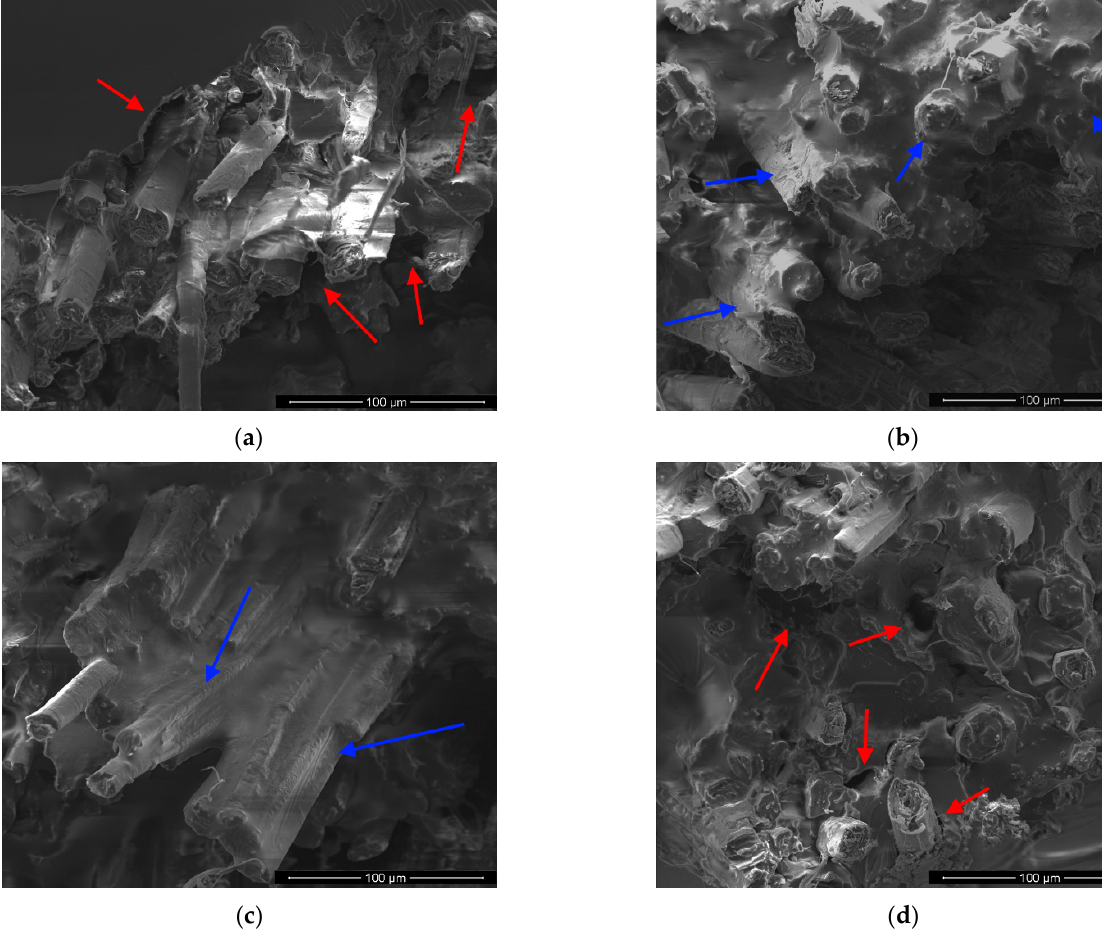
Figure 10. SEM micrographs at high magnification (1000×) of tensile fractured surfaces: ( a ) R, ( b ) C5, ( c ) C10 and ( d ) C20